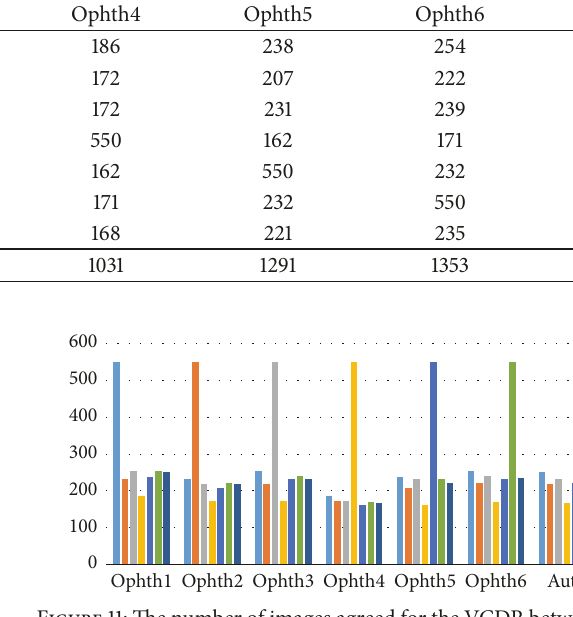
Figure 11: The number of images agreed for the VCDR between the ophthalmologists and the algorithm. 𝑥 -axis represents the number of 6 ophthalmologists and the algorithm. 𝑦 -axis represents the number of agreed